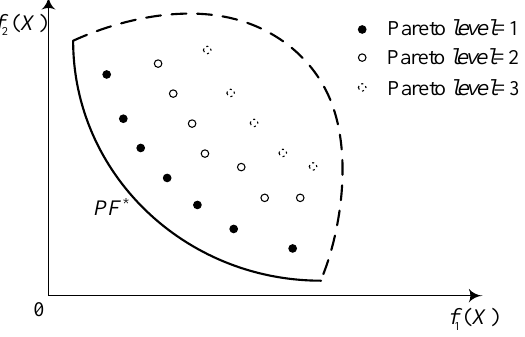
Figure 4. Pareto levels of population.